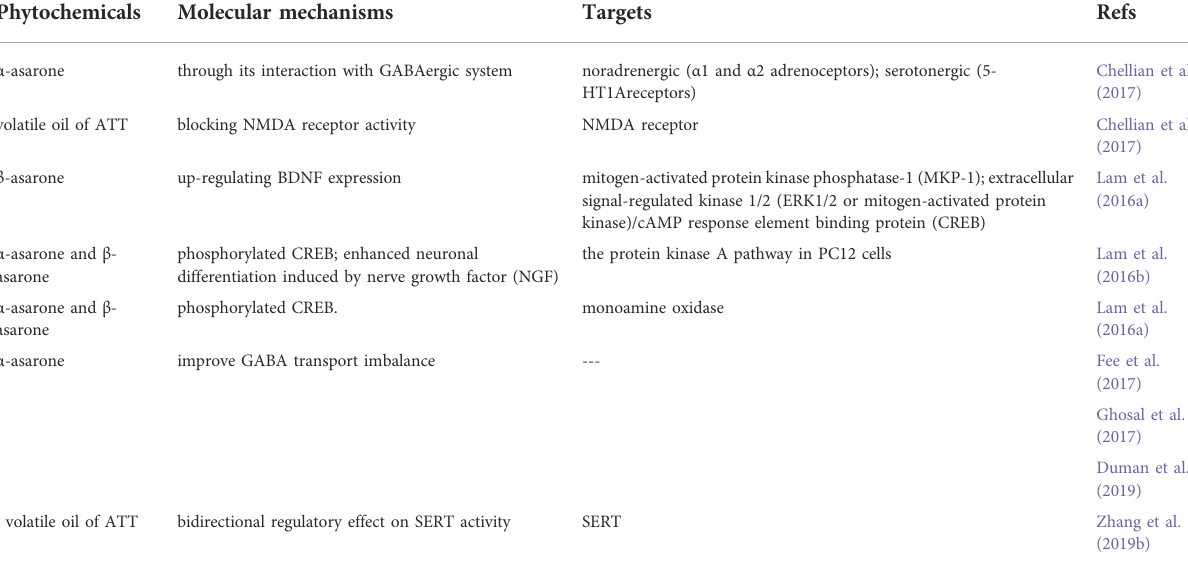
TABLE 5 The targets and mechanisms of antidepressant effect of